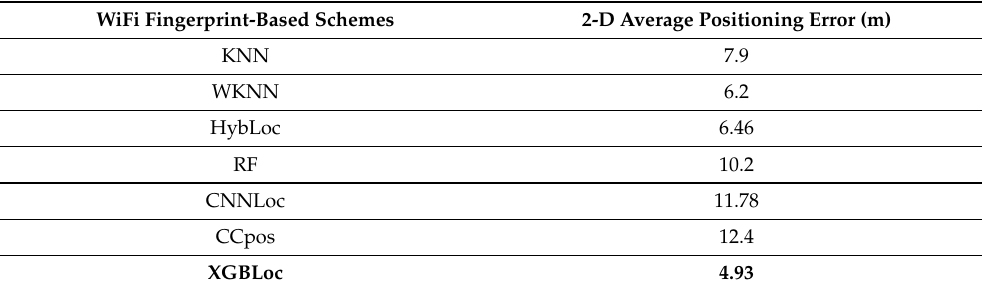
Table 8. Regression results of existing and proposed schemes on the UJIIndoorLoc dataset. WiFi Fingerprint-Based